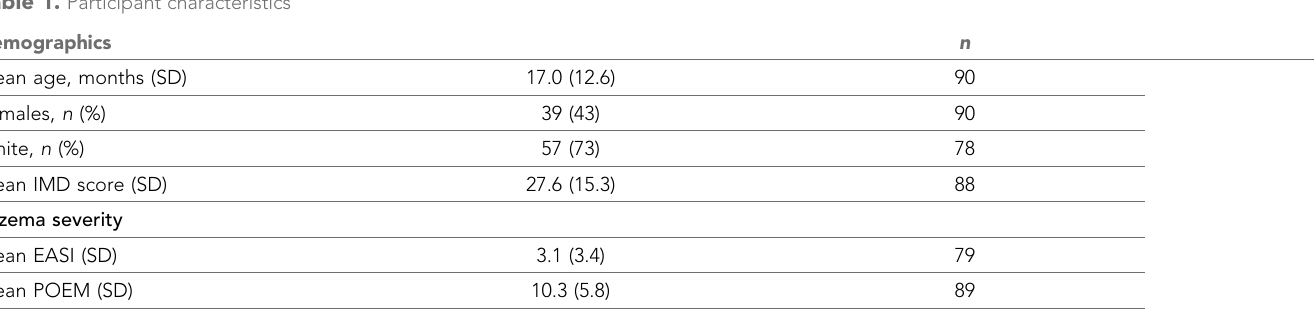
Table 1. Participant